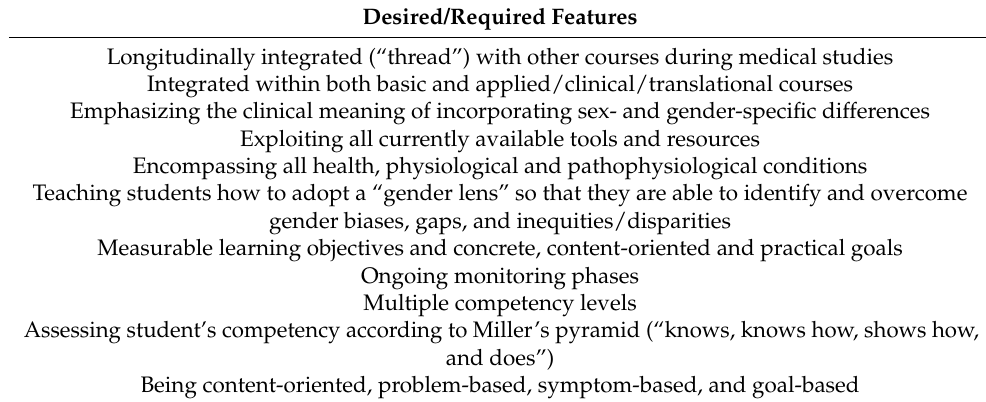
Table 4. List of desired/required features of a potentially successful sex- and gender-based medical